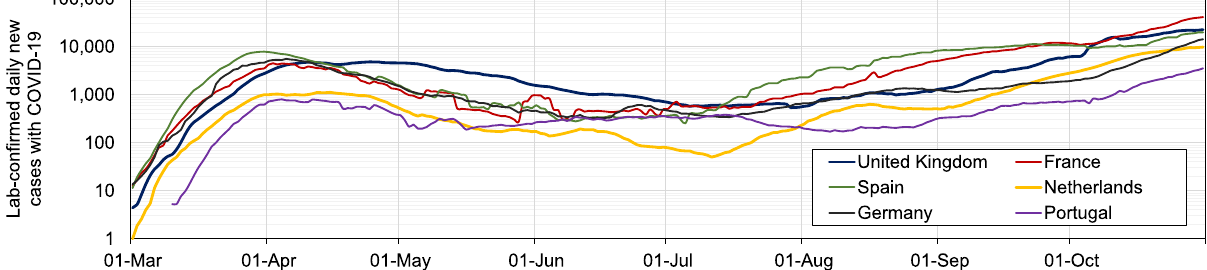
Fig. 1. A line graph for the number of lab-con fi rmed daily cases with COVID-19 for some of the infected countries in Europe. The number of cases are displayed using a logarithmic scale to base 10. Coverage: 1 March to 31 October. Data source: